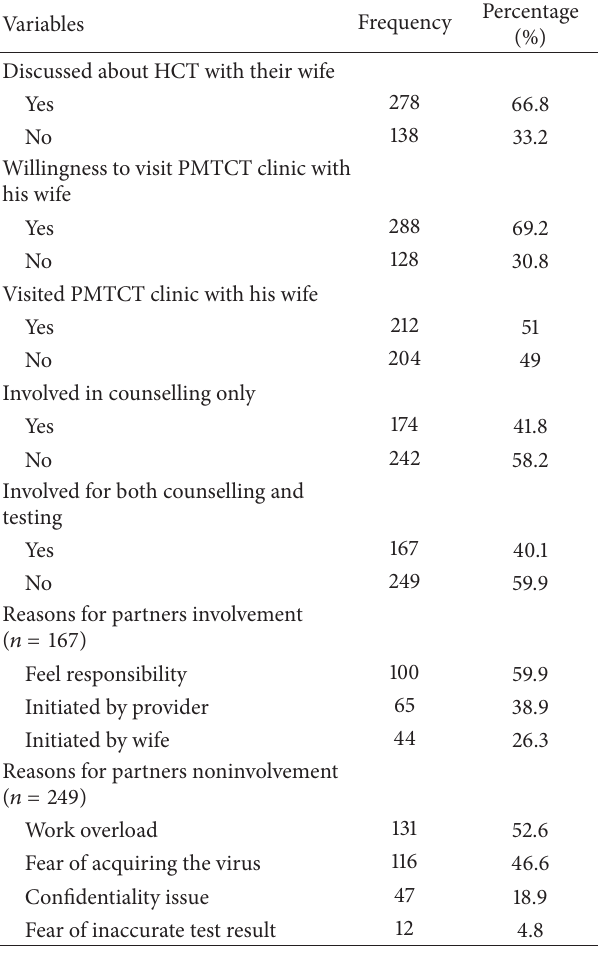
Table 3: Level of involvement of partners of pregnant women towards HCT in Gondar town, Northwest Ethiopia,